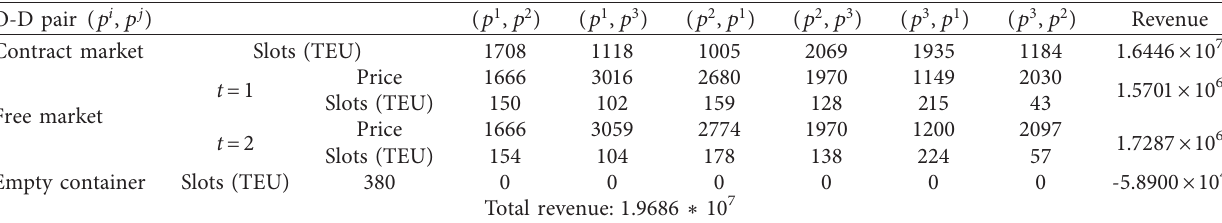
Table 5: Results of slot allocation just considering basis price in Model I.